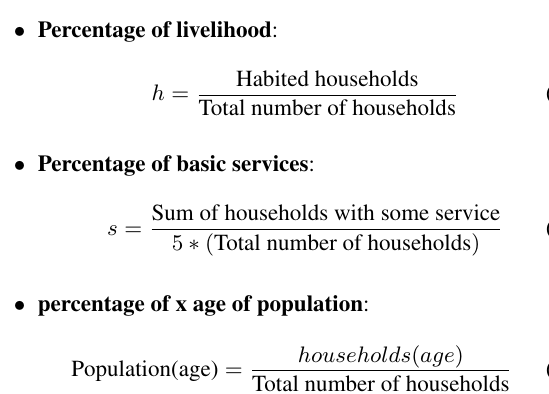
Figure 5. Number of establishments per